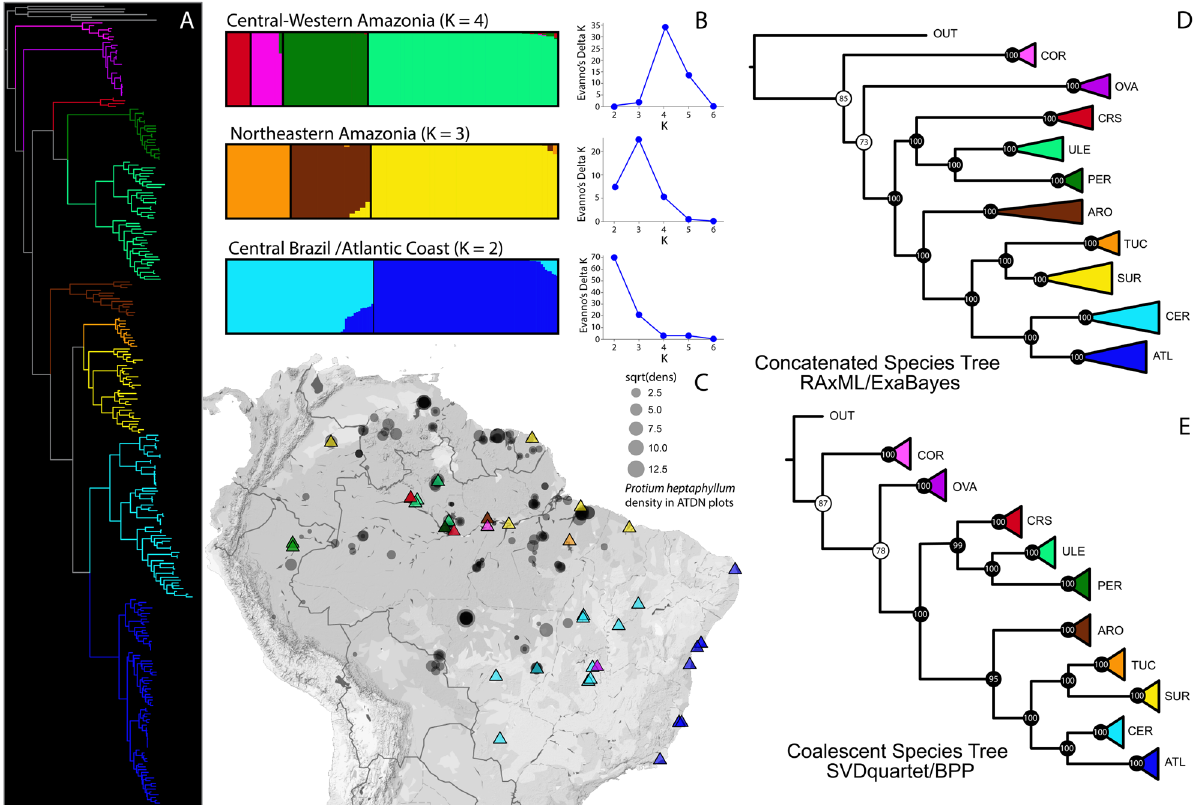
Figure 1. Phylogenetic reconstruction and population genetic structure of Protium heptaphyllum s.l. (Aubl.) Marchand. (A) Maximum likelihood (RAxML) phylogeny of P. heptaphyllum inferred with 1000 bootstrap replicates using the GTRGAMMA substitution model. The dataset consists of 285 samples and 6,234 loci. Trees were inferred from concatenated data sets using RAxML version 8.2.1060 (https:// github. com/ stama tak/ stand ard- RAxML) and consensus tree visualized using the R package ape version 5.3 (http:// ape- packa ge. ird. fr/). (B) STRU CTU RE analysis identified three main clusters that encompasses the Central/West and North/East of Amazonia, and the Central and Atlantic Coast of Brazil. The bar graphs represent a subsequent STRU CTU RE run within each geographic group based on a combination of 10 replicate runs. Colors indicate the assignment of each individual to a particular genetically similar cluster. The number of clusters within each geographic region were identified based on the ΔK statistics. Analysis and figure visualization were performed in STRU CTU RE version 2.3.4 (http:// web. stanf ord. edu/ group/ pritc hardl ab/ struc ture. html). (C) The location of each sampled population is displayed on the map (triangle symbols). Colors indicate the population assignment to a particular genetic cluster. Circle symbols corresponds to the plot location where P. heptaphyllum s.l . was sampled by the Amazon Tree Diversity Network (ATDN). Circle sizes are equivalent to the square root of density values per hectare in each of the ATDN plots. Figure generated using the R package ggmap version 3.0.0 (https:// www. rdocu menta tion. org/ packa ges/ ggmap/ versi ons/3. 0.0). (D,E) Species tree inference based on concatenated data matrices ran in RAxML and ExaBayes software and based on the multispecies coalescent model ran in SVDquartet and BPP software, respectively. Node values represent bootstrap support and posterior probabilities for each clade. White circles correspond to support values that are not identical between RAxML bootstrapping and ExaBayes posterior probabilities. In this case, the lower support value was displayed in the figure. Both species trees were visualized using FigTree version 1.1 (http:// tree. bio. ed. ac. uk/ softw are/ figtr ee/). See Figure S2 and Table S2 for more information about the putative new Functional variation and environmental response. We found that P. heptaphyllum s.l . exhibited a complex and variable profile of functional trait characters with clear functional differences in mean trait values and trait breadth among lineages identified by the morphological and molecular analyses (Fig. 4). Lineages from the Amazon region occupying white-sand ecosystems and flooded igapó forests had very narrow trait variation. For example, the TUC (orange) and CRS (red) populations exhibit very low within-lineage variation in most functional traits (Fig. 4). In contrast, populations from Central Brazil Cerrado (light blue) and Atlantic Forest (dark blue) often showed greater intra-populational trait variation corresponding to the different habitats the trees inhabit. For instance, P. heptaphyllum populations from the Atlantic Forest were commonly sampled across forest-savanna ecotones (e.g. rainforest and restinga transect gradients, populations with code MUS and PON, respectively) and leaf and habit traits in these populations exhibited phenotypic plasticity, corresponding to the local soil fertility and water availability (i.e. stunted trees or shrubs less than 2 m tall inhabiting dry and poor